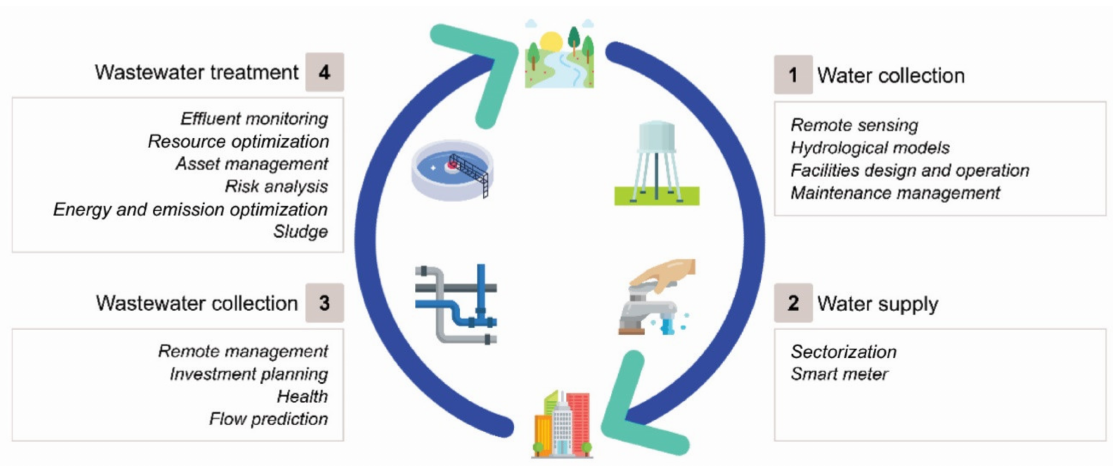
Figure 3. Digitization in the urban water cycle